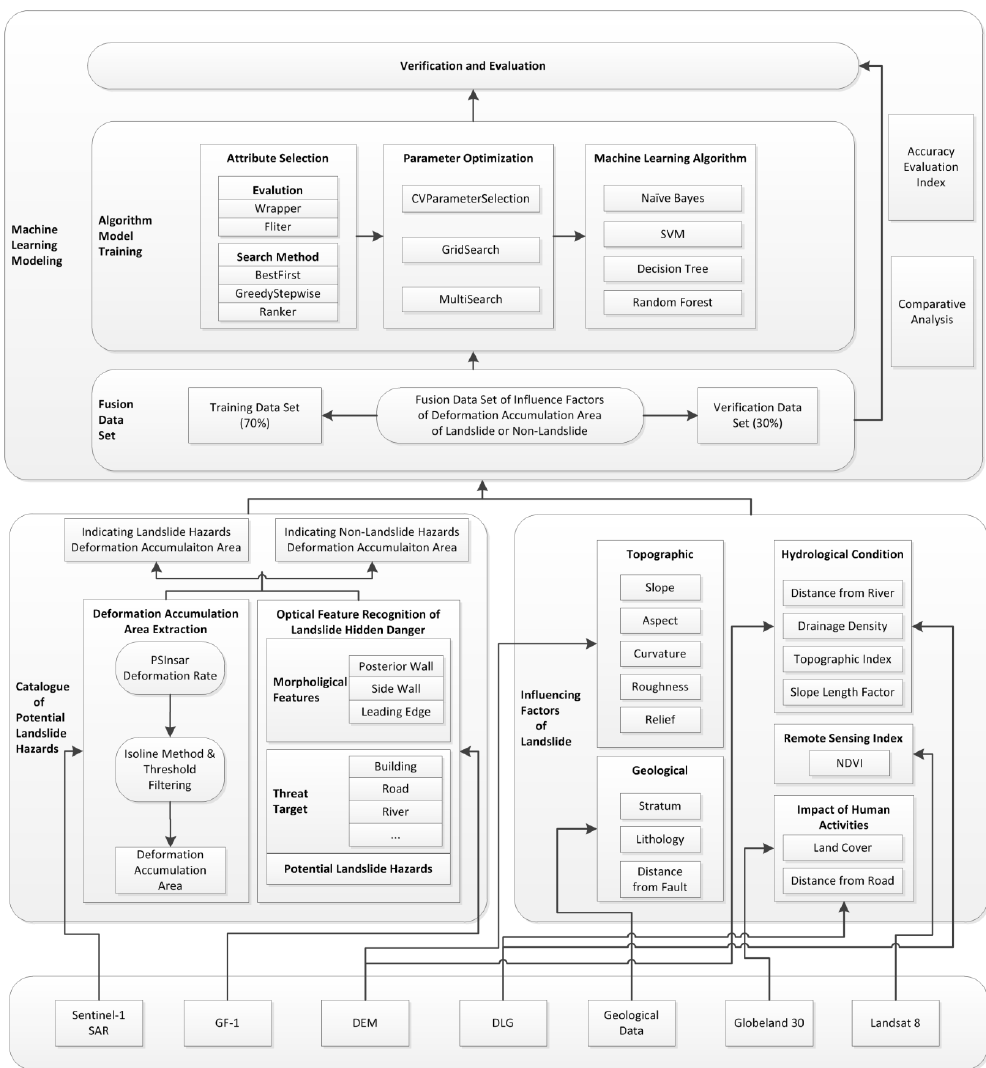
Figure 5. Overall research methodology.